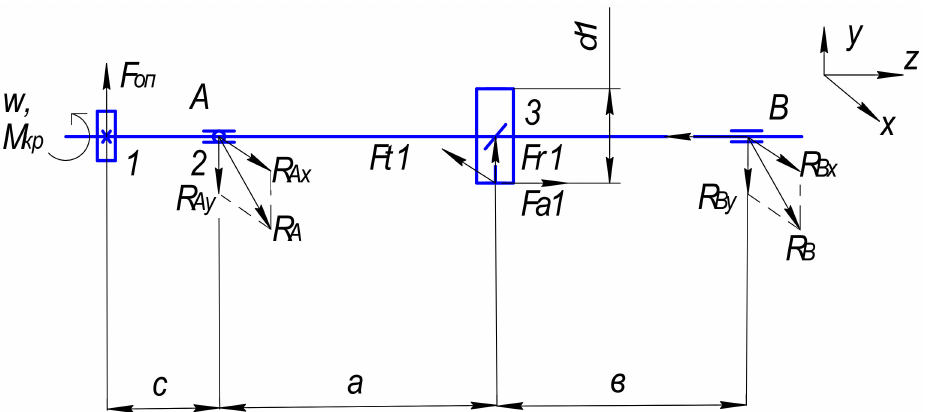
Figure 2. Design Scheme of the Transmission Shaft: x, y, z are coordinate systems of axes; a, b, c are distances between bearings; d1is the gear diameter; A, B are designations of shaft bearings; w, Mt is the torque; Fct is the cantilever power from belt drive; F t1 , F r2 , F a1 are the direction of forces on the gear and on the wheel; R A , R Ax , R ay , R B , R Bx , R By are the directions of radial reactions in bearings A, B,